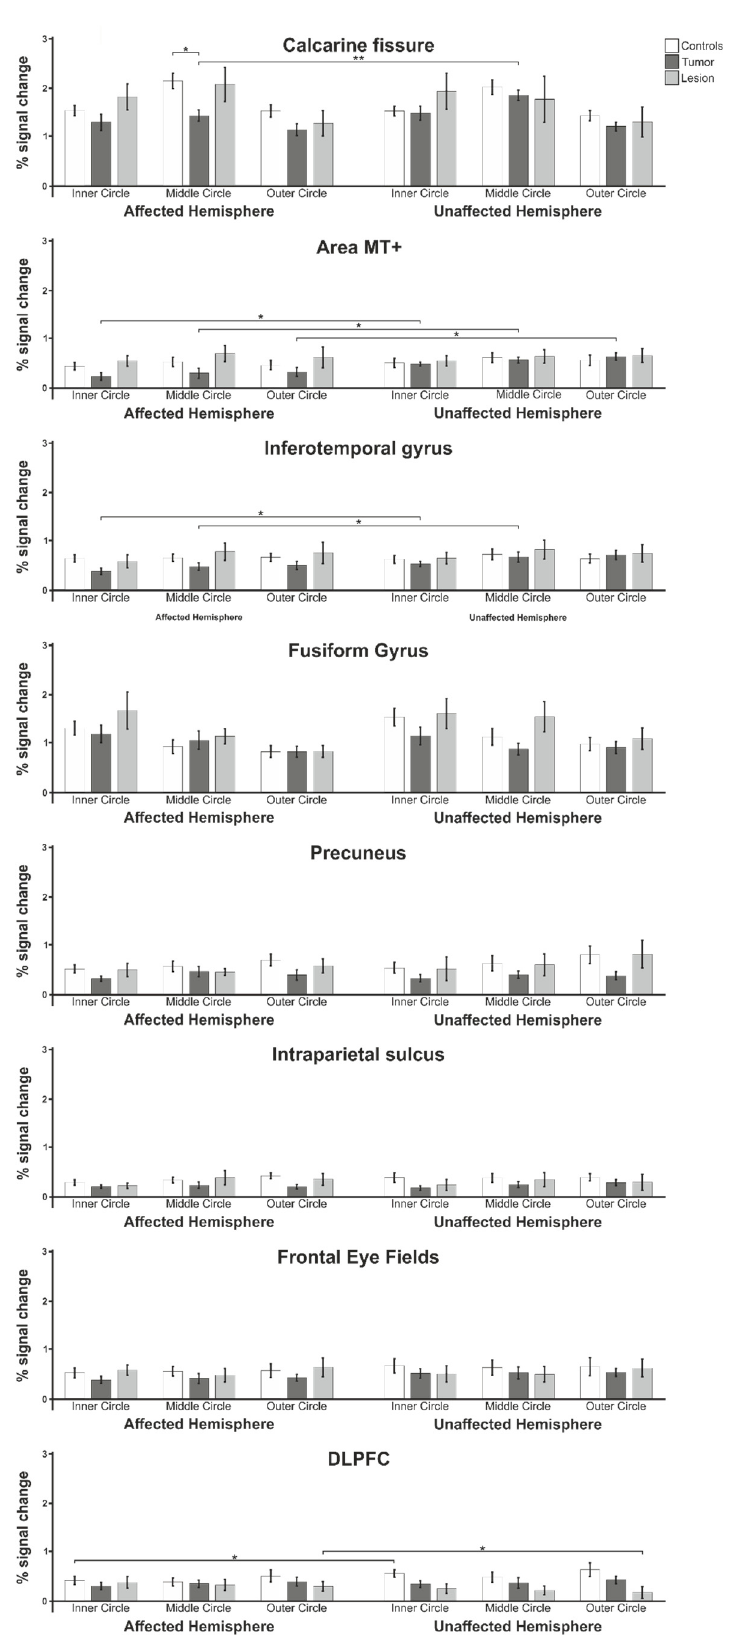
Figure 6. Mean percent signal changes of the analyzed Regions of Interest within the healthy control group compared to the tumor patient and lesion patient groups for the lesion-affected and unaffected hemispheres. Statistically significant results are marked with * for p < 0.05 and ** for p < 0.01.